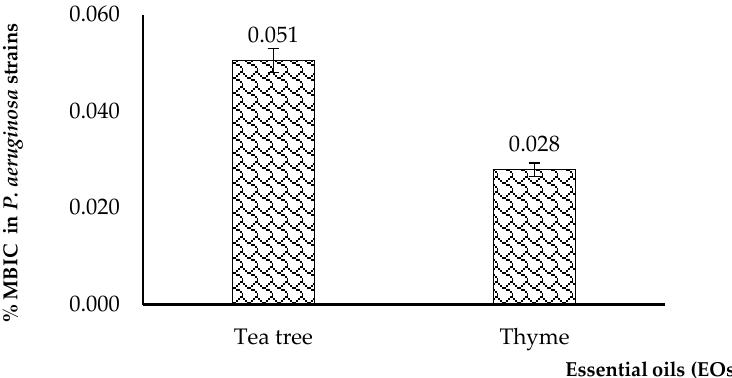
Figure 10. Comparison of the average MBICs of tea tree and thyme EOs (%) in all the analyzed P. aeruginosa strains. p < 0.05 when comparing average MBICs of thyme to tea tree EOs.